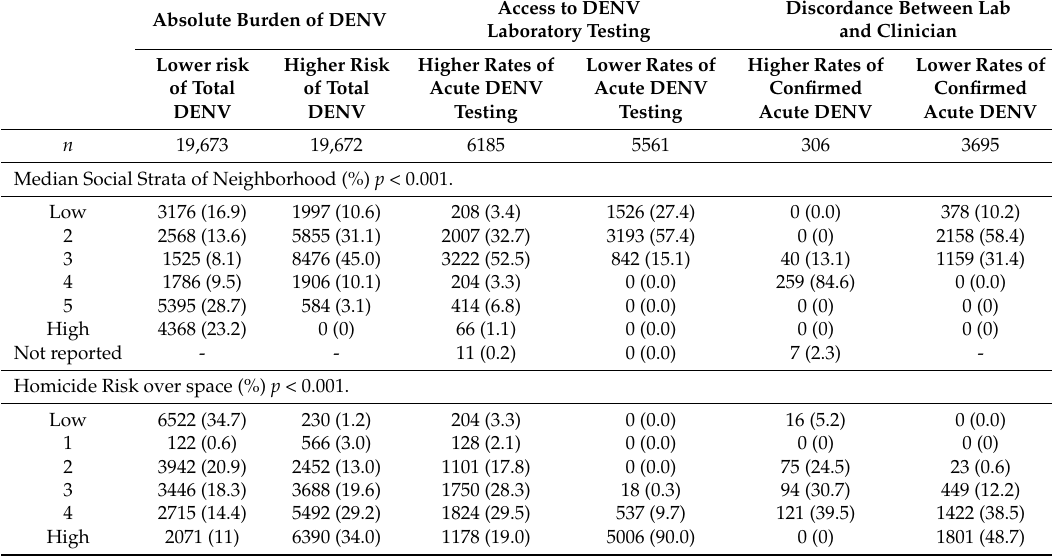
Table 2. Absolute burden of DENV by social strata and total homicide risk; DENV acute testing rates by social strata and total homicide risk; and confirmed DENV acute by social strata and total homicide risk. Access to DENV Discordance Between Lab Absolute Burden of DENV Laboratory Testing and Clinician Higher Rates of Lower Rates of Lower Rates of Higher Rates of Higher Risk Lower risk Confirmed Confirmed Acute DENV of Total Acute DENV of Total Acute DENV Acute DENV Testing Testing DENV DENV n 19,673 19,672 6185 3695